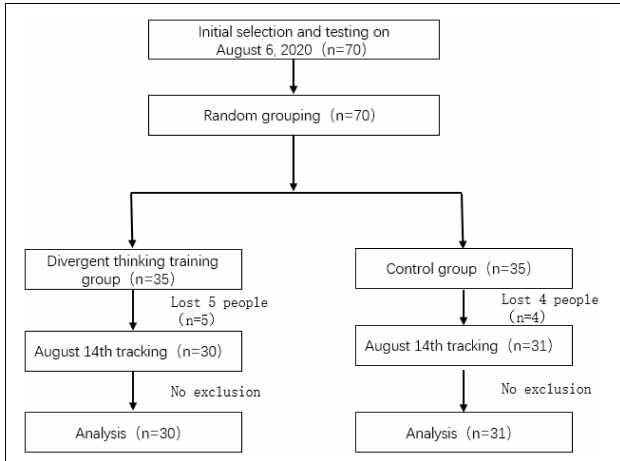
FIGURE 1 | The illustration of the procedure of this